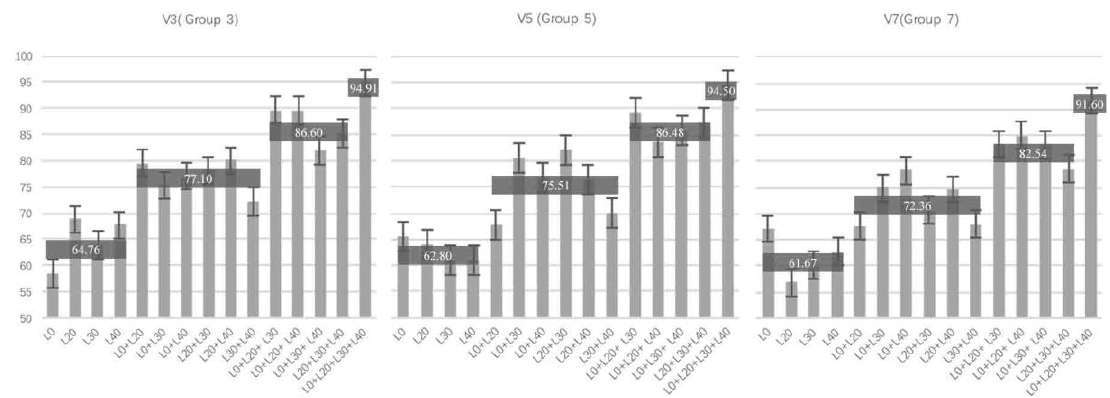
Figure 6. Accuracy of the gait recognition (%) of the groups at three speeds. The testing data (group 3 at V3, group 5 at V5, group 7 at V7) is from all four loads, the training data is comprised of the data from one load (four kinds), two loads (six kinds), three loads (four kinds), and four loads (one kind) at each speed. The average accuracy of the gait recognition (%) for all the one load, two loads, three loads, and four loads, at each speed are labeled in the picture.